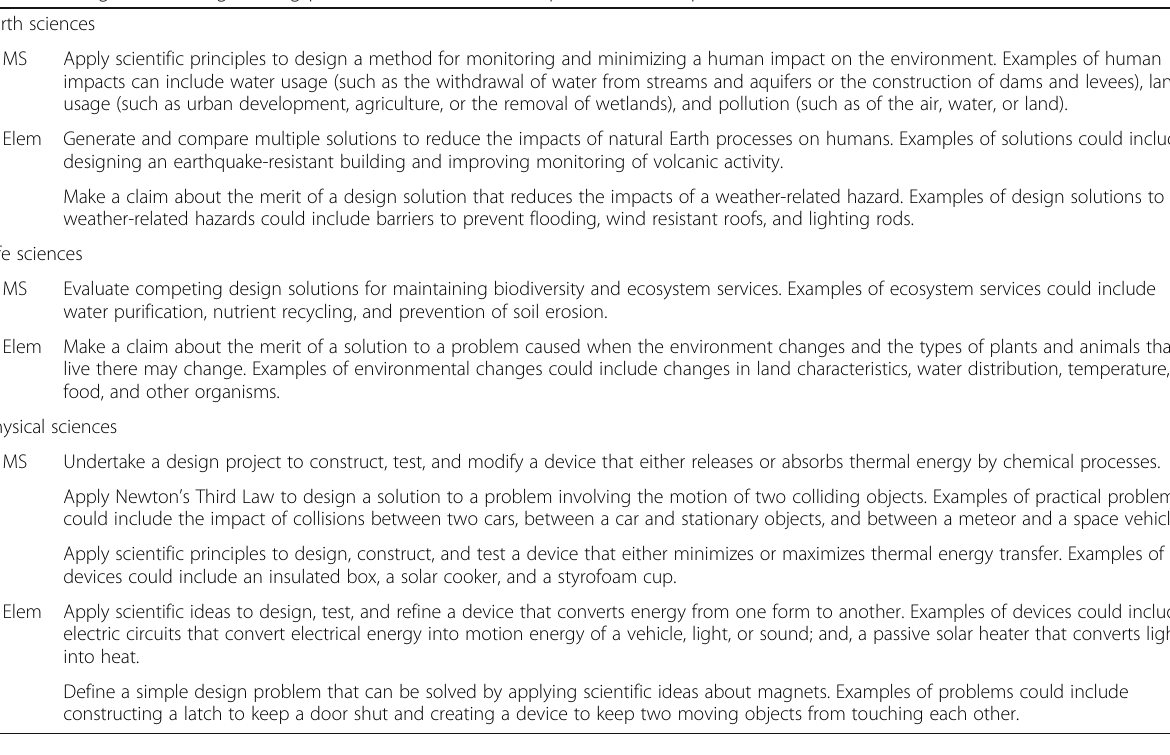
Table 6 Integration of engineering practices within the NGSS performance